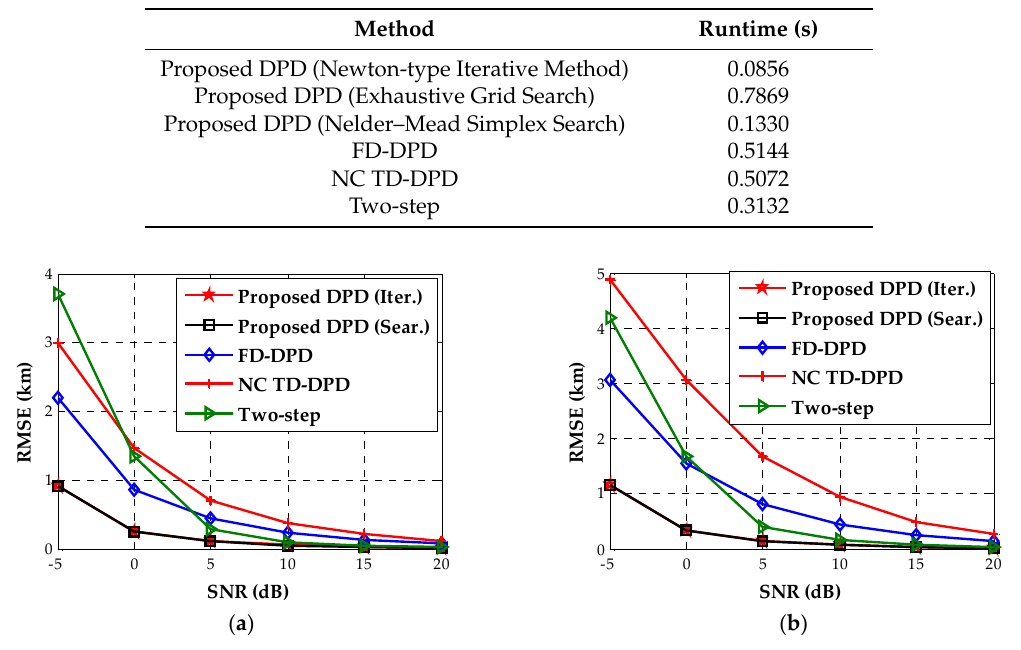
Table 4. Average runtime for far-field sources.